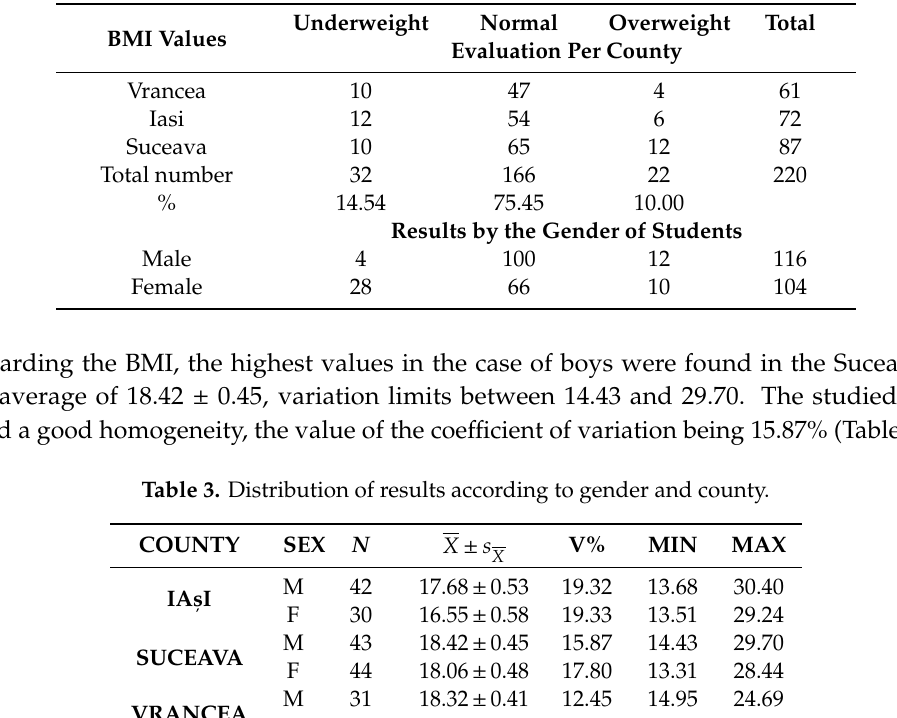
Table 2. Body Mass Index (BMI) values among the research students.